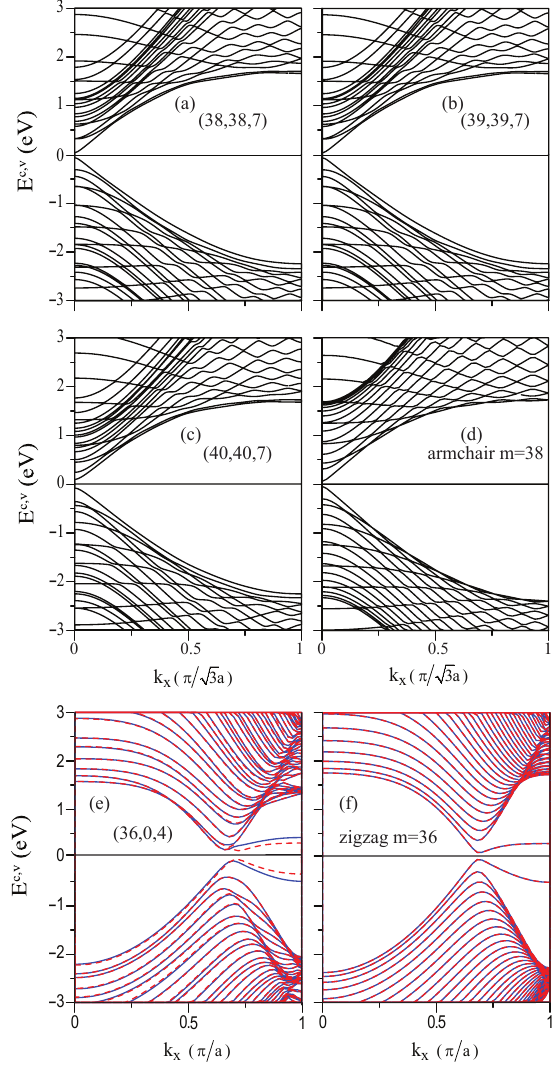
Figure 4. Band structures of the armchair system for ( a ) (38,38;7), ( b ) (39,39;7), ( c ) (40,40;7); ( d ) flat GNR with m = 38, and zigzag system for ( e ) (36,0;4); ( f ) flat GNR with m = 36. The energy bands are all doubly degenerate for both spin states: spin-up and spin- down. Each energy dispersion has the local minimum or maximum at k x = 0 and 1 and also at other wave vectors; that is to say, there are extra band-edge states except those at k x = 0 and 1. In the vicinity of E F , the highest occupied state (HOS) and the lowest unoccupied state (LUS) occur at the same wave vector ( k x = 0.1), which, thus, leads to a direct energy gap of E g = 0.181 eV, as shown in Table 1. Contrarily, the armchair (39,39;7) CNS (Figure 4b) possesses an indirect energy gap. Associated with this gap are the highest occupied and the lowest unoccupied states that appear, respectively, at k x = 0.01 and 0.13, and they are separated by a gap size of E g = 0.112 eV. These two energy bands are relatively smooth near k x =0 without obvious dispersions. Such 3N-width characteristic is similar to that of the flat graphene nanoribbon [37]. Both the armchair ( 40, 40; 7 ) CNS with a ( 3 N + 1 ) width (Figure 4c) and the armchair ( 38, 38; 7 ) CNS with a ( 3 N + 2 ) width have direct energy gaps. The important differences between them are that the former has a smaller gap of E g = 0.323 eV and strongly non-monotonous energy dispersions. In addition, energy spacing of the k x = 0 state between two energy bands nearest to E F = 0 is higher than the energy gap. Apparently, there are certain important differences among the 3 N - , ( 3 N + 1 ) - and ( 3 N + 2 ) -width systems. On the other hand, the CNSs are in